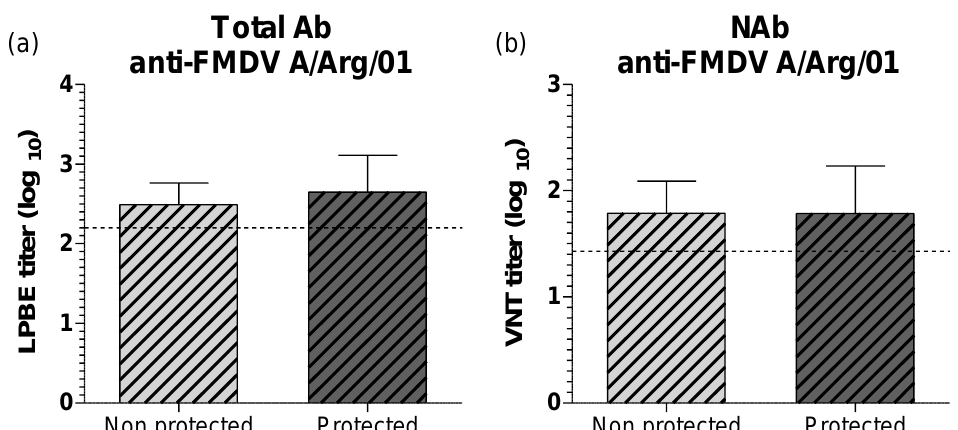
Figure 4. Total and neutralizing antibody responses against FMDV A/Arg/01 strain in protected and non-protected animals against the heterologous challenge at 30 dpv. Total FMDV-specific antibodies were measure by LPBE ( a ) and neutralizing antibodies were measure by VNT ( b ). Results are expressed as the log10 of the mean titers against heterologous strain, A/Arg/01. Dotted lines depict the titers corresponding to the EPP 75 for A/Arg/01 strain for each serological assay. Bars represent mean value ± SD.